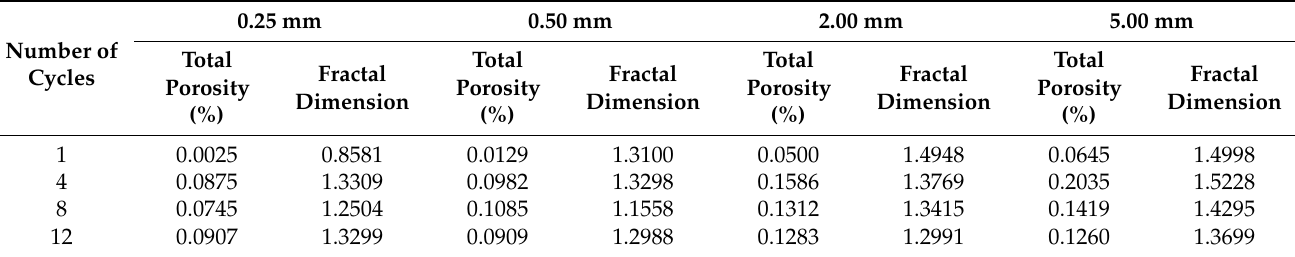
Table 6. Total porosity and fractal dimension of red clay.